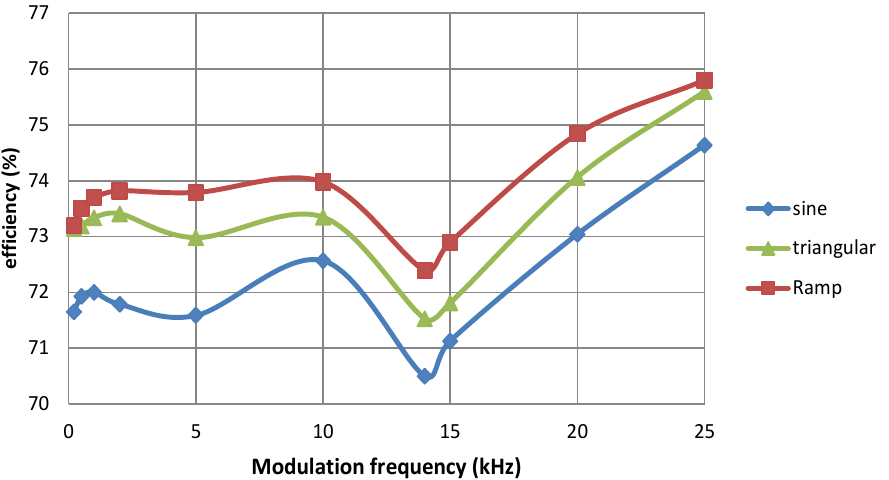
Figure 14. Measured efficiency versus f m when periodic SFM (with different modulation waveforms and ∆ f peak = 12 kHz) is used. Note: the efficiency of the WPT system without the spread spectrum is 76.7%.